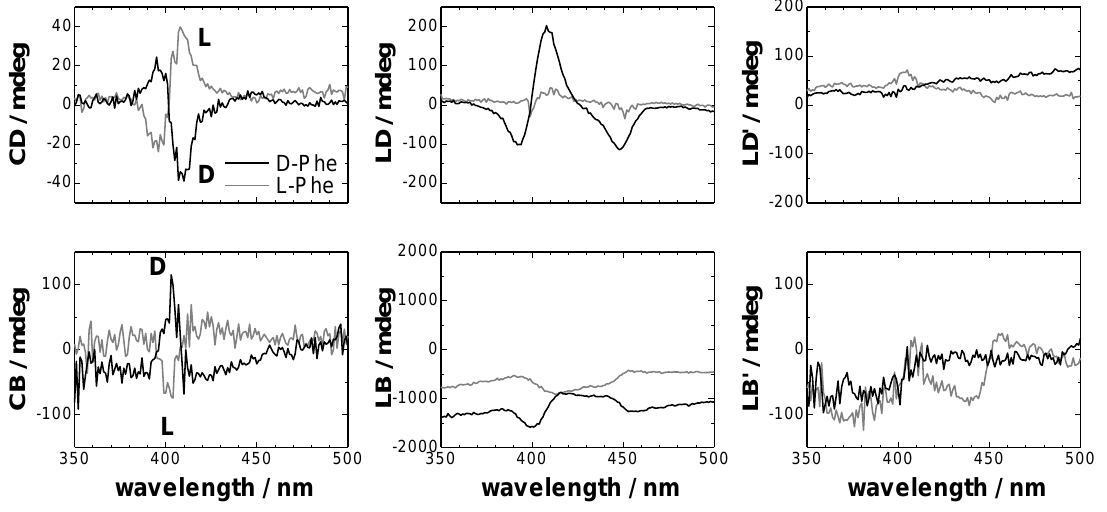
Figure 5. Circular and linear dichroisms and circular and linear birefringences of TPyP-CuTPPS hetero-aggregates obtained from the inversion of the Mueller-Jones matrices. [TPyP] = 8 × 10 −6 M, [CuTPPS] org [HClO ] + [NaClO ] = 0.1 M, pH 2.3, toluene:chloroform = 96:4, v/v, t = 30 4 aq 4 aq